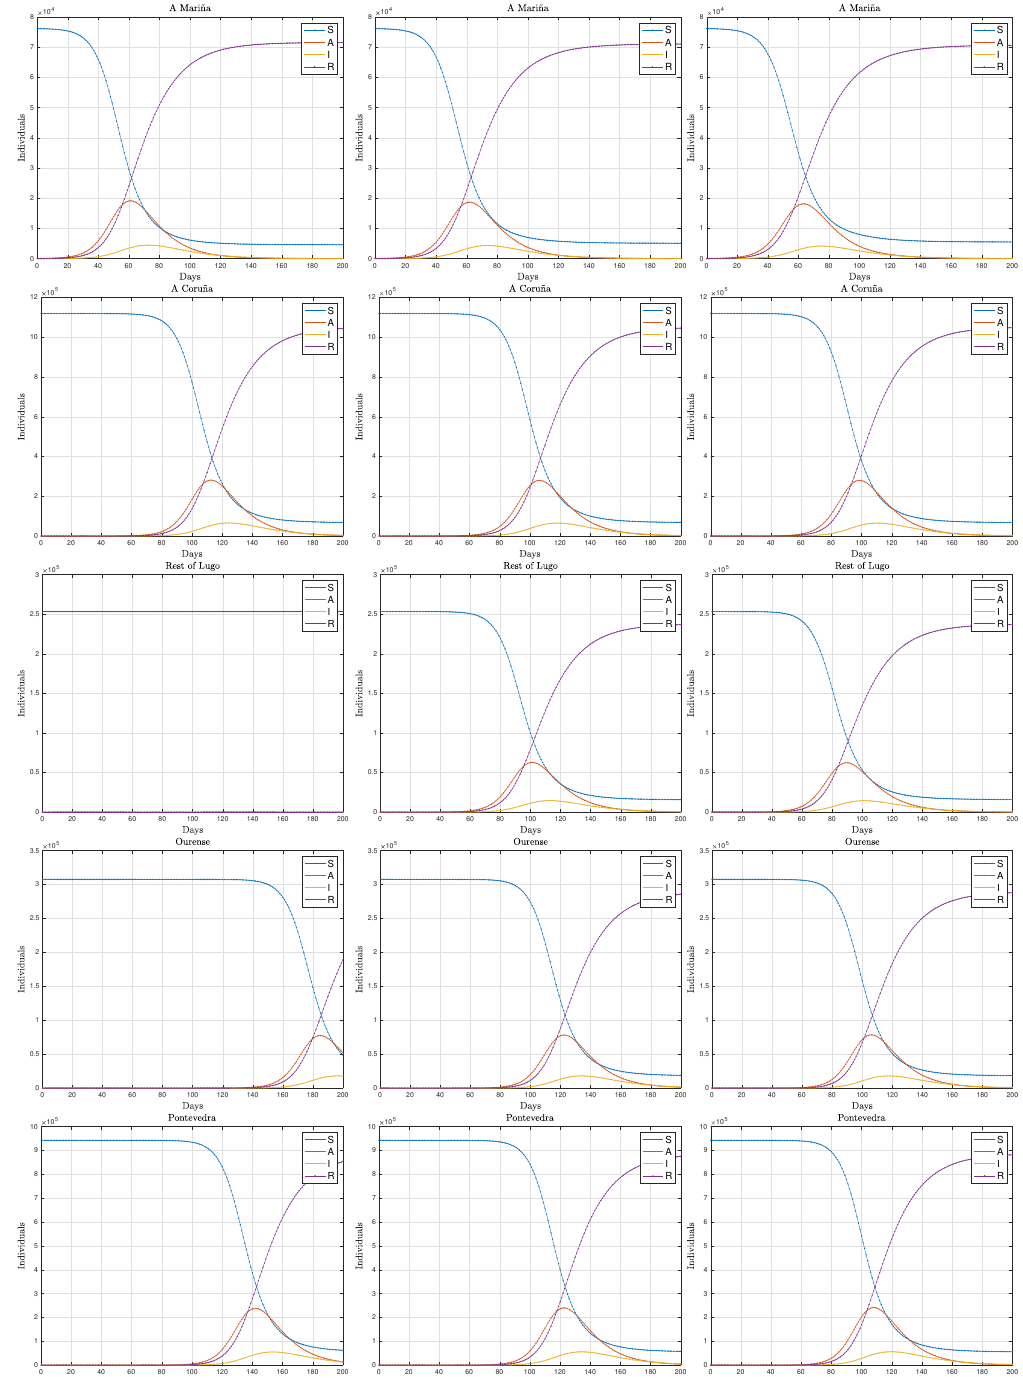
Figure 3. Simulation of the evolution of COVID-19 in five regions of the Autonomous Community of Galicia assuming that initially A Mariña has 40 asymptomatic infectious individuals and A Coruña, rest of Lugo (Lugo without A Mariña), Ourense and Pontevedra have none, and considering different mobility restrictions among the five regions. From left to rigth: very resticted mobility, restricted mobility and unrestricted